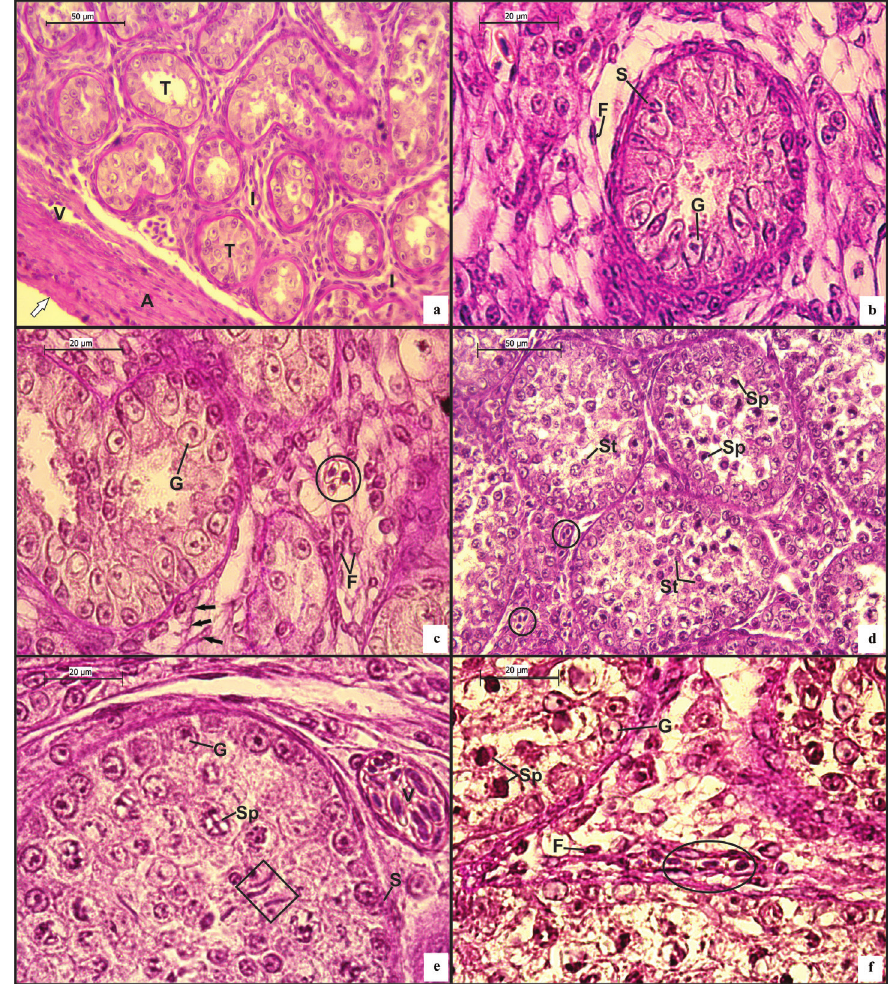
Figure 2. Histological section from Ara ararauna testicle during the dry season in a, b, c and during the rainy season in d, e and f. In a: testicular capsule with its serous tunic (arrow) and albuginea tunic (A), with collagen fibers and blood vessels (V), interstitium (I) and seminiferous tubules (T). In b: the seminiferous tubule presenting only spermatogonia (G) and Sertoli cells (S), fibroblast (F) in the interstitium. In c: interstitium constituted by Leydig cells (circle), fibroblasts (F) and collagen fibers (arrow); spermatogonia (G). In d: several cell types in the tubular wall: primary spermatocytes (Sp), round spermatids (St), Leydig cells (circle) in the interstitium. In e: Sertoli cell (S), spermatogonia (G), elongated spermatids (square), a blood vessel in the interstitium (V). In f: Leydig cells (circle) and fibroblasts (F) in the interstitium, spermatogonia (G) and primary spermatozoa (Sp) in the seminiferous